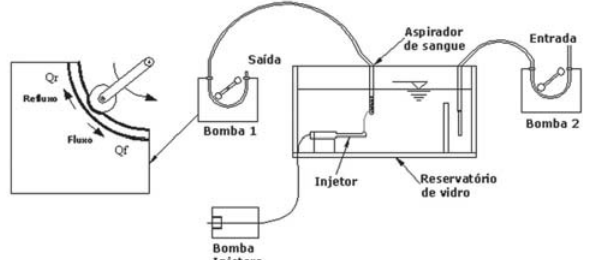
Fig. 1 – Ilustração da configuração usada para visualização em